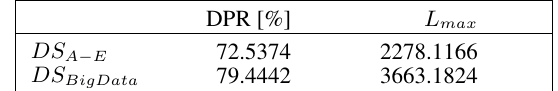
Table 6. Performance measures for the track detection (detection performance ratio DPR, and the maximal length L max of the connected components) regarding the individual data